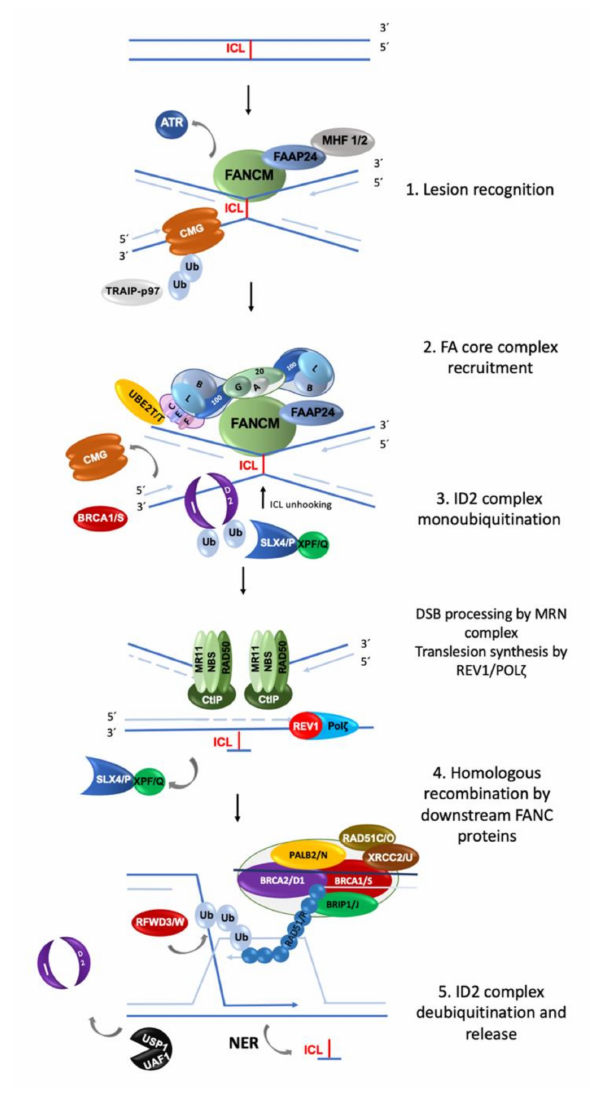
Figure 1. Summary of the activity of FANC proteins in the FA / BRCA pathway. The main function of this pathway is the removal of DNA interstrand crosslink (ICL); 22 FANC proteins participate in: (1) Lesion recognition. FANCM and its partners recognize ICLs during the convergence of two replication forks and promote ATR activation; the CMG helicase complex is unloaded to allow the approach of the leading strands to the ICL. (2) FA core complex recruitment. FANCM and its partners recruit the FA core complex and UBE2T / FANCT (the “upstream” proteins), to exert their E3-ubiquitin ligase activity and monoubiquitinate the FANCI and FANCD2 heterodimer (also known as the “ID2 or central complex”). (3) ID2 complex monoubiquitination. The monoubiquitinated central complex activates the endonucleolytic function of FANCP-SLX4-FANCQ / XPF resulting in the unhooking of the ICL from one of the DNA strands and the generation of a DSB. Both DNA ends of the DSB are processed by the MRN / CtIP complex to form a 3 (cid:48) overhang. In the opposite strand, the unhooked ICL has now become an adduct; to bypass it, the REV1-polymerase ζ complex (including FANCV protein) performs translesion synthesis of the new strand. (4) The processed DSB is repaired by homologous recombination. The “downstream” FANCD1 / BRCA2, FANCN / PALB2, FANCS / BRCA1, FANCJ / BRIP1, FANCO / RAD51C and FANCR / RAD51 proteins coordinate to coat the processed DNA strand of the DSB with RAD51 / FANCR and paralogs RAD51C / FANCO, to invade the newly polymerase ζ -synthesized double strand of its sister chromatid, using it as a template to recover the original nucleotide sequence. (5) The cycle finishes with deubiquitination and unloading of the ID2 complex by USP1-UAF1 and the removal of the ICL-adduct by NER (nucleotide excision repair) pathway